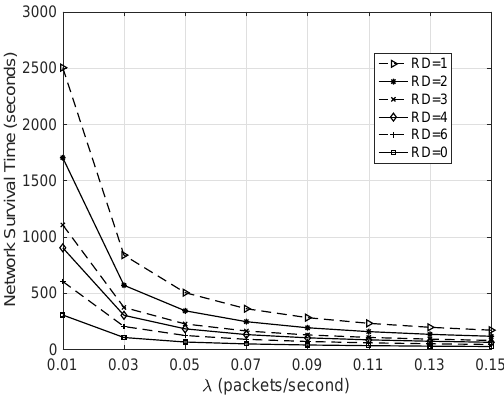
Figure 7. Network survival time versus λ